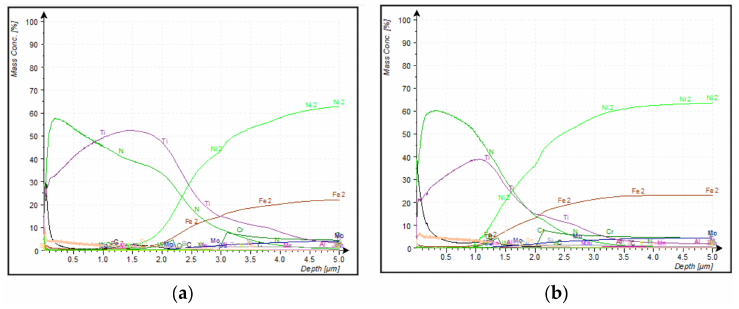
Figure 10. Percentage mass concentration vs. depth of TiN coating in ( a ) Z2 surface and ( b ) Z3